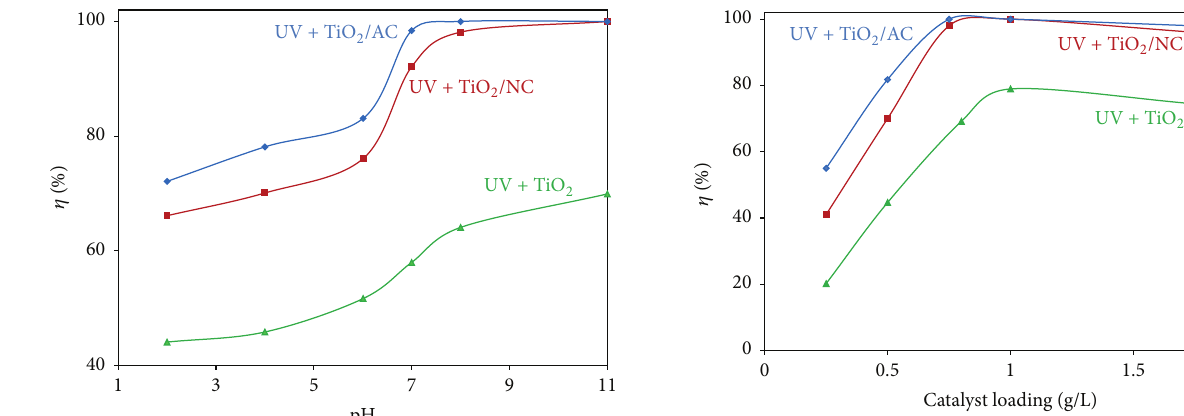
Figure 5: Effect of pH on photocatalytic degradation of MG using TiO 2 (P25), TiO 2 /NC, and TiO 2 /AC (initial concentration of MG = 75 mg/L, photocatalyst amount = 0.75 g/L, and irradiation time = 180 min).